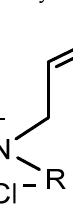
Figure 1. General structure of methyl alkyl diallyl ammonium chloride.